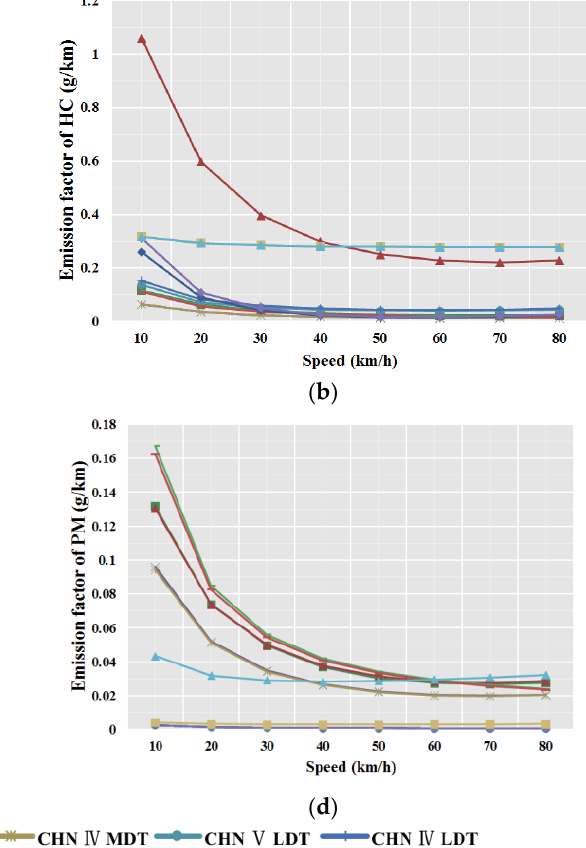
Figure 13. The emission factors of different tested vehicles; ( a ) Emission factors of CO; ( b ) Emission factors of HC; ( c ) Emission factors of NOx; ( d ) Emission factors of PM